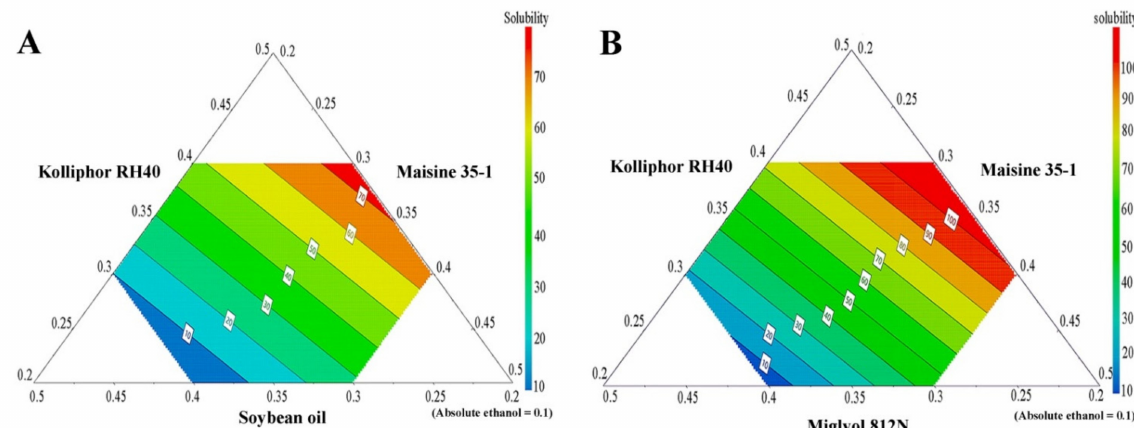
Figure 3. The prediction contour plots of APC solubility in SNEDDS formulations; long-chain triglyceride SNEDDS system ( A ) and medium-chain triglyceride SNEDDS system ( B